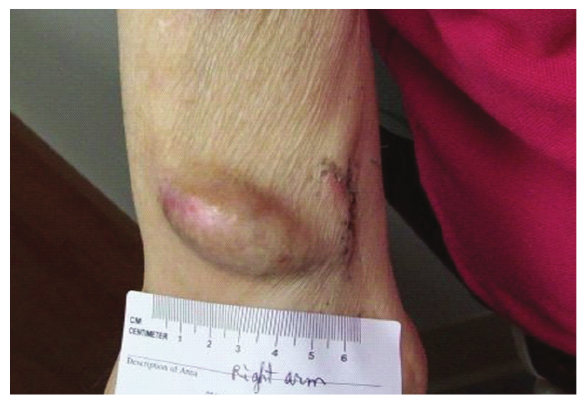
Figure 1: Right upper arm AV fistula aneurysm of the patient. Size is approximately 6 × 3cm.